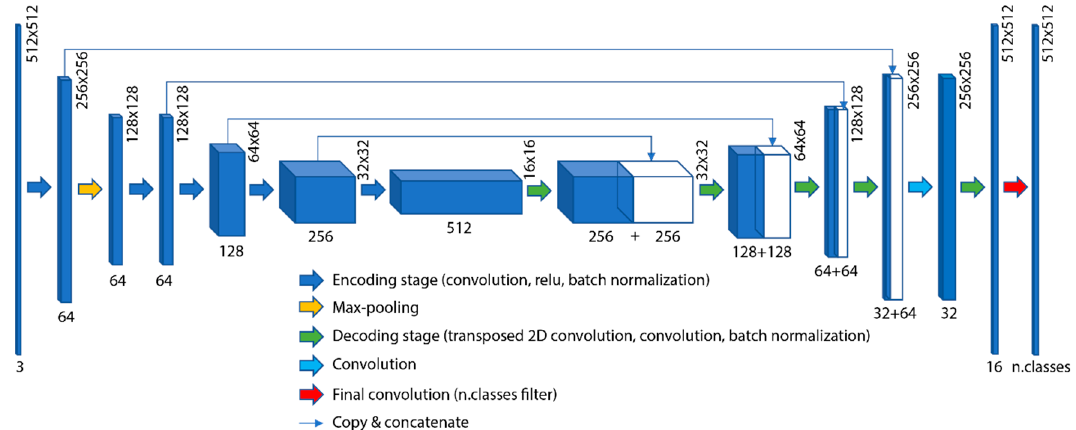
Figure 4. Architecture of the deep network employed to perform blood vessel detection. A UNET with ResNet34 backbone was implemented using Keras framework.